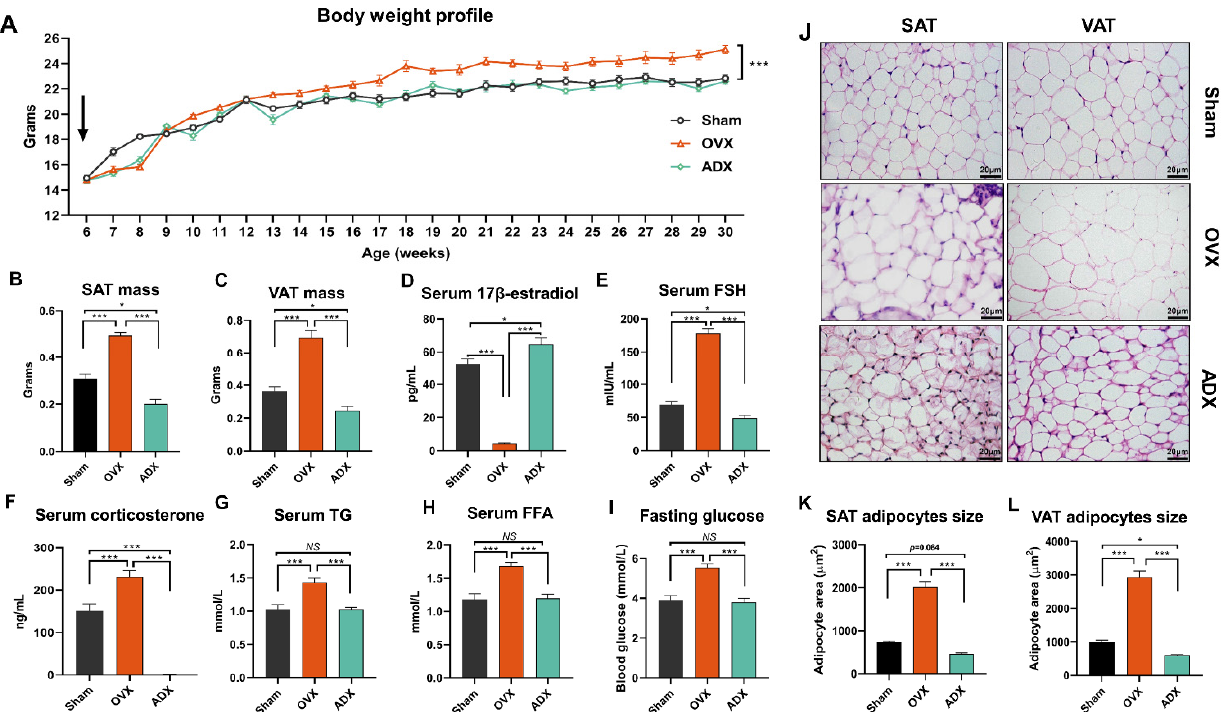
Figure 1. Opposite response in endocrine hormones and the AT expansion caused by ADX and OVX. ( A ) The body weight profile of the sham control, OVX and ADX mice across the entire experimental periods. ( B , C ) SAT and VAT weight of the sham control, OVX and ADX mice. ( D – I ) Serum 17 β -estradiol, FSH, corticosterone, triglyceride (TG), free fat acid (FFA) and fasting blood glucose concentrations of the sham control, OVX and ADX mice. ( J ) Representative histological images of SAT and VAT of the sham control, OVX and ADX mice. Scale bar: 20 μ m. ( K – L ) Average adipocytes size of SAT and VAT of the sham control, OVX and ADX mice. All data met the criteria for normal distribution with similar variance. Statistical analysis was performed using repeated-measures 2- way ANOVA with Holm–Sidak’s multiple comparisons ( A ) and one-way ANOVA, followed by Tukey’s test ( B – E , F – L ). Data are expressed as mean ± SEM. NS , not significant, * p < 0.05, *** p < 0.001.